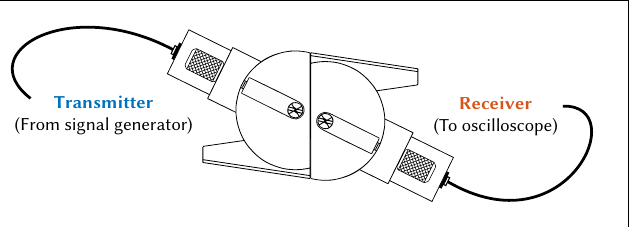
Figure 8. Cross-sectional diagram of wedge-to-wedge time-of-flight measurement